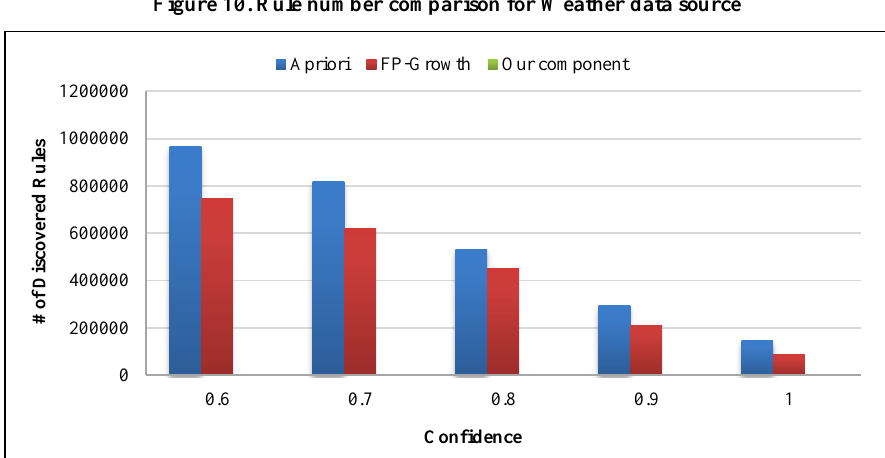
Figure 11. Rule number comparison for Lymphography data